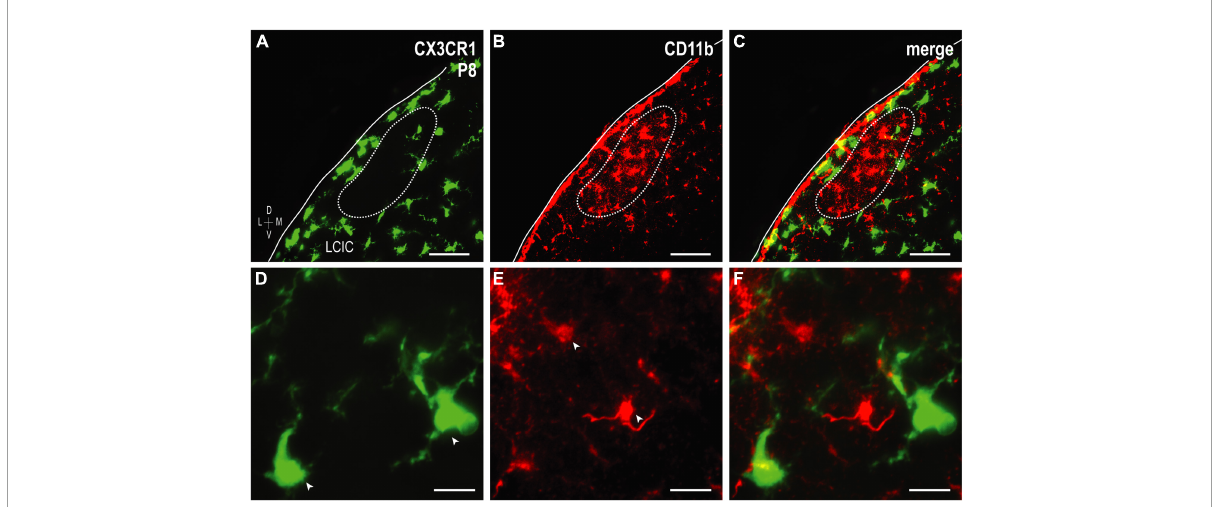
FIGURE7 Higher magnification series of integrin α M (CD11b) expression in P8 fractalkine receptor (CX3CR1)-GFP tissue showing distinct microglial cell (MGC) subsets. CX3CR1-expressing microglia (green) at P8 surround modules [ dashed contours , (A–C) , for more see Brett et al., 2022] where complement receptor expression (CD11b, red) is most concentrated. At every examined timepoint with notable CD11b expression (i.e., not P36), lateral cortex of the inferior colliculus (LCIC) CX3CR1 (D) and CD11b (E) expression was non-overlapping (F) , providing evidence that supports the notion of different MGC populations with unique molecular signatures. Arrowheads in (D,E) indicate unique microglial subpopulations. Scale bars in (A–C) = 50 µ m; (D–F) = 20 µ m.